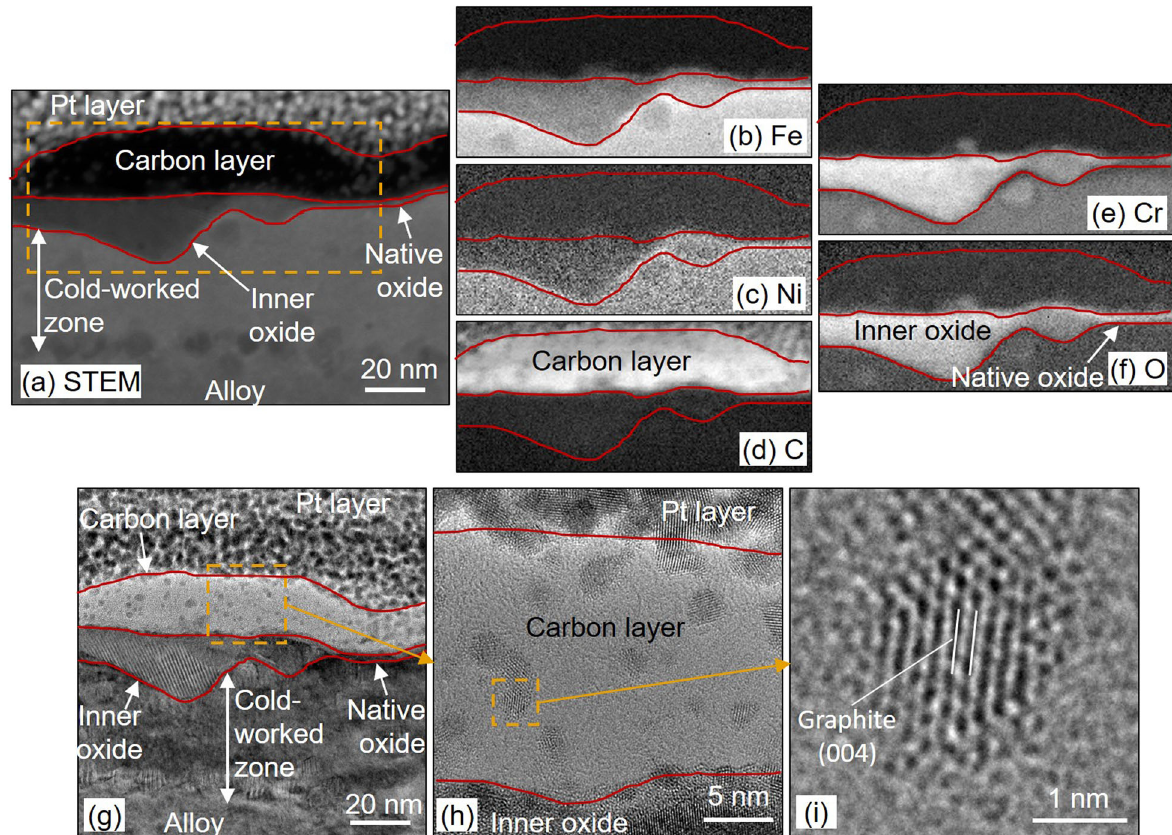
Fig. 8 Cross-sectional TEM analysis of Fe22Ni22Cr after AP-XPS in high purity CO 2 . a STEM reference image. b – f EELS mapping of the area indicated in a by the orange dashed line. g – i HRTEM images showing the carbon layer at increasing magni fi cation. The oxide layer and carbon layer are both delineated by the red